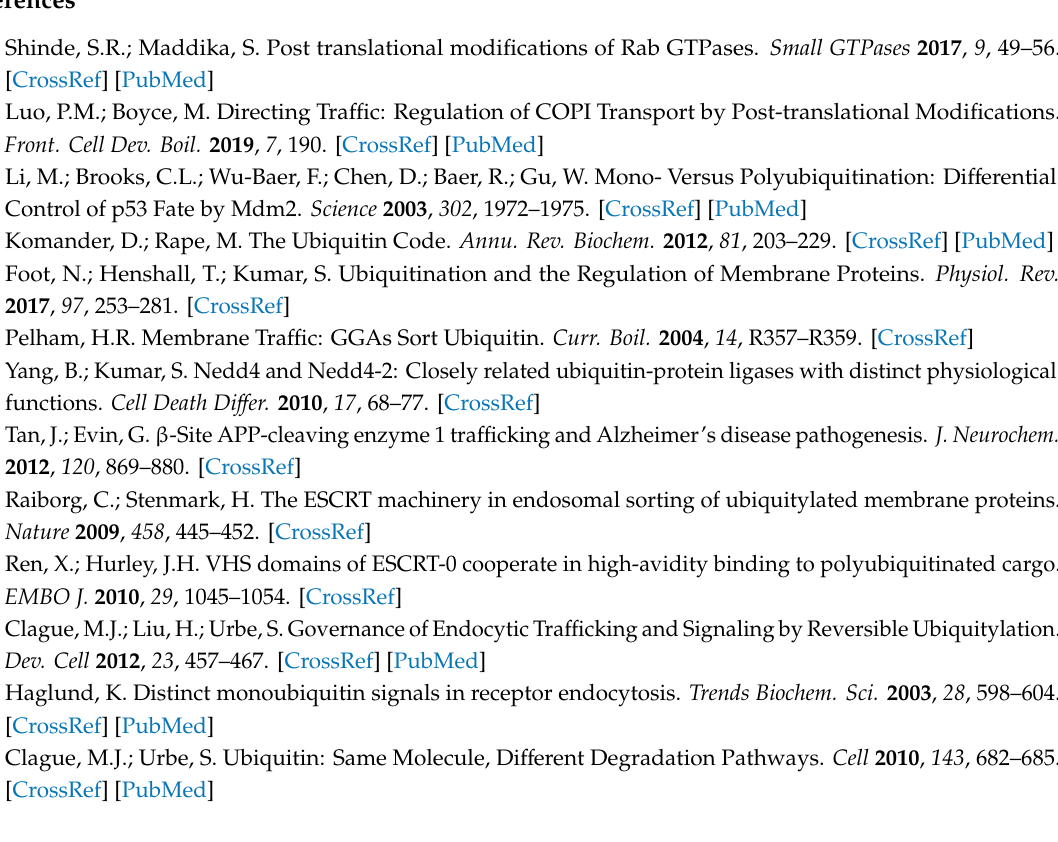
Figure S1: siRNA sequences directed against human PSMD14 used for Validation Stage; Figure S2: Primer pairs sequences used for RT-qPCR; Figure S3: The PSMD14 DUB inhibitor CZM increases the Golgi apparatus area; Figure S4: CZM causes the accumulation of KDELR1-GFP at the Golgi apparatus; Figure S5: E ff ect of CZM on proteasome activity; Figure S6: E ff ect of CZM and MG132 on basal macroautophagy; Figure S7: Distribution of RAB1A upon CZM treatment; Figure S8: ATG9A is distributed in the swollen Golgi apparatus upon CZM